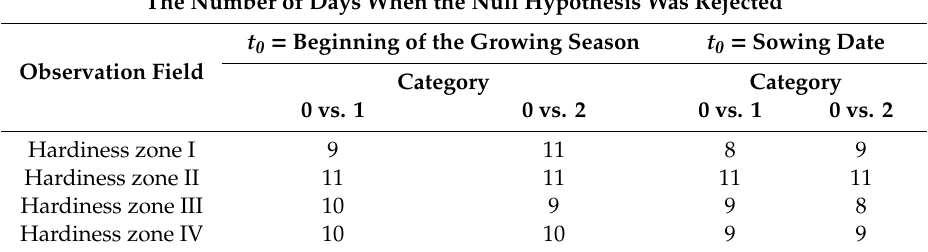
Table 3. Results of the statistical feature evaluation.